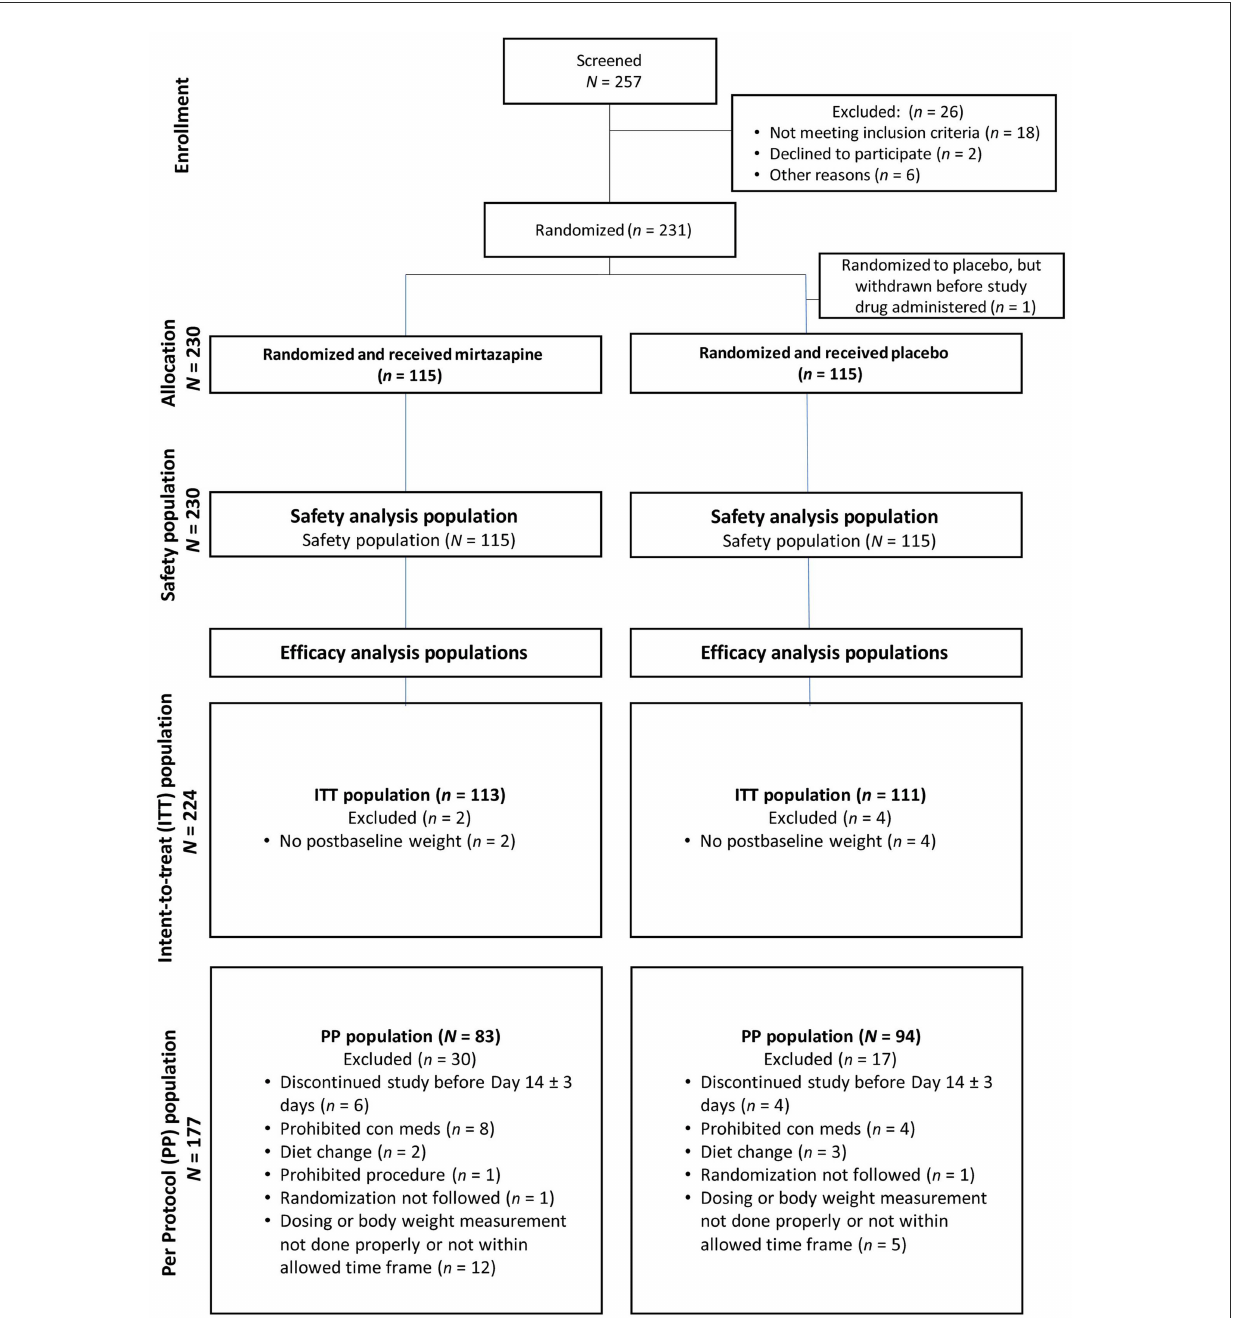
FIGURE1 In this study, there were 257 cats screened; 26 were excluded and ultimately 231 were randomized to treatment. The Safety Population consisted of all cats randomized to either treatment group who received at least one dose of study drug. The Intent-to-Treat (ITT) population included all cats randomized and who received at least one dose of study drug and had at least one postbaseline body weight measurement. The Per Protocol (PP) population included all cats completing the study through and including Day 14. One cat with pre-existing dental disease underwent dental prophylaxis, and this cat was not included in the effectiveness